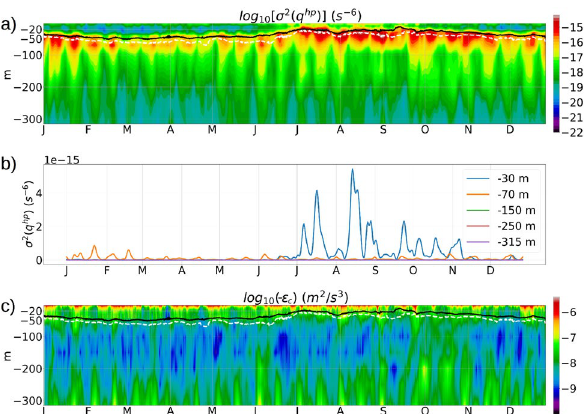
2 Figure 17. ( a ) Variance ( σ ) of the high-pass filtered potential vorticity ( q hp ) at a location in transect B to the east of Anegada (transect B shown in figure S5, supplementary material). The black line shows the MLD , and the dashed white line denotes the depth of maximum vertical stratification in the water column (transition-layer 2 ( q hp ) depth 52 ). ( b ) Time-series of σ at different depths. ( c ) Dissipation ǫ c at the same location in the transect